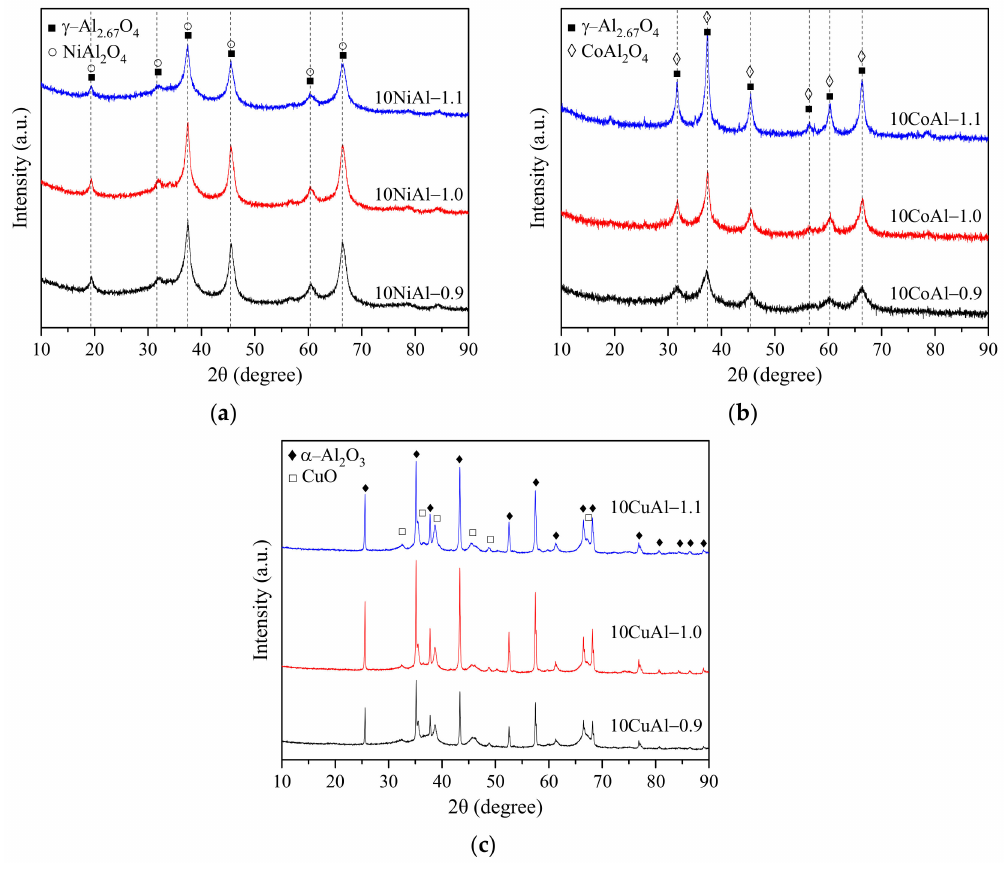
Figure 3. XRD patterns of ( a ) 10NiAl − x, ( b ) 10CoAl − x and ( c ) 10CuAl − x calcined